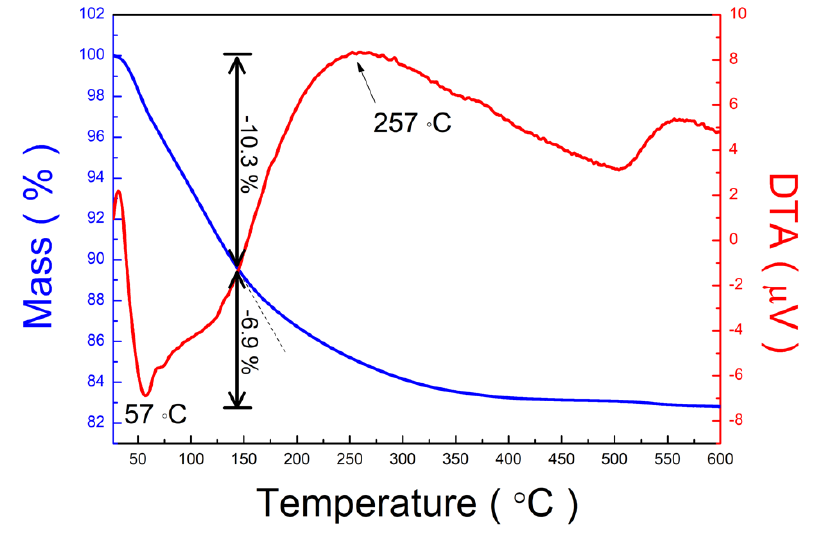
Figure 1. Thermogravimetric (TG) and differential thermal analysis (DTA) curves of as-synthesized peroxo-titanate nanotubes (PTNTs) heated at 10 °C/min in an air atmosphere.